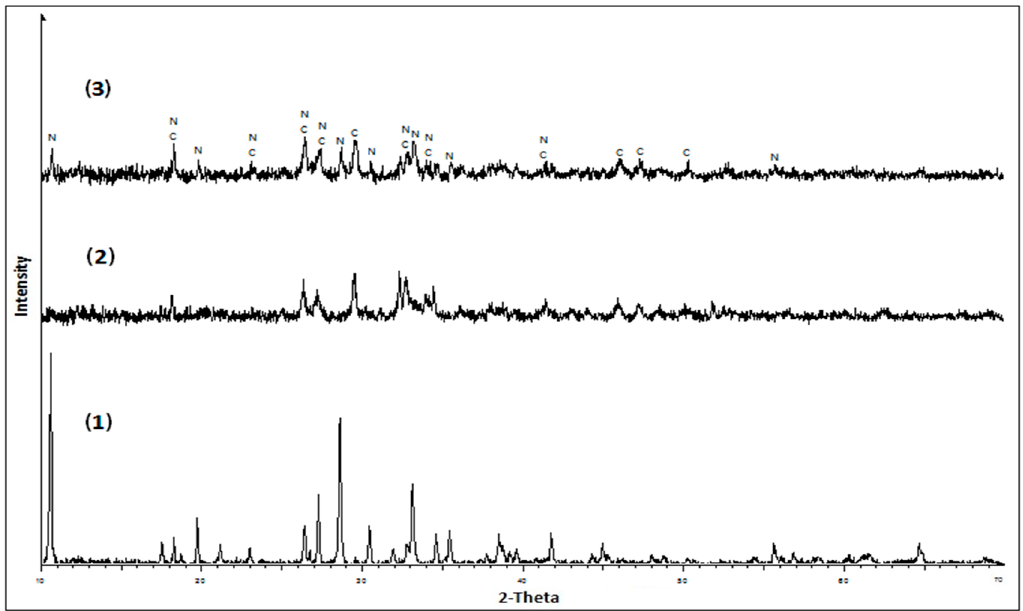
Figure 6. X-ray phase analysis of the cement stone after 28 days of hardening: (1) substandard nephrite (n); (2) Portland cement (c); (3) cement with a 30% nephrite additive.